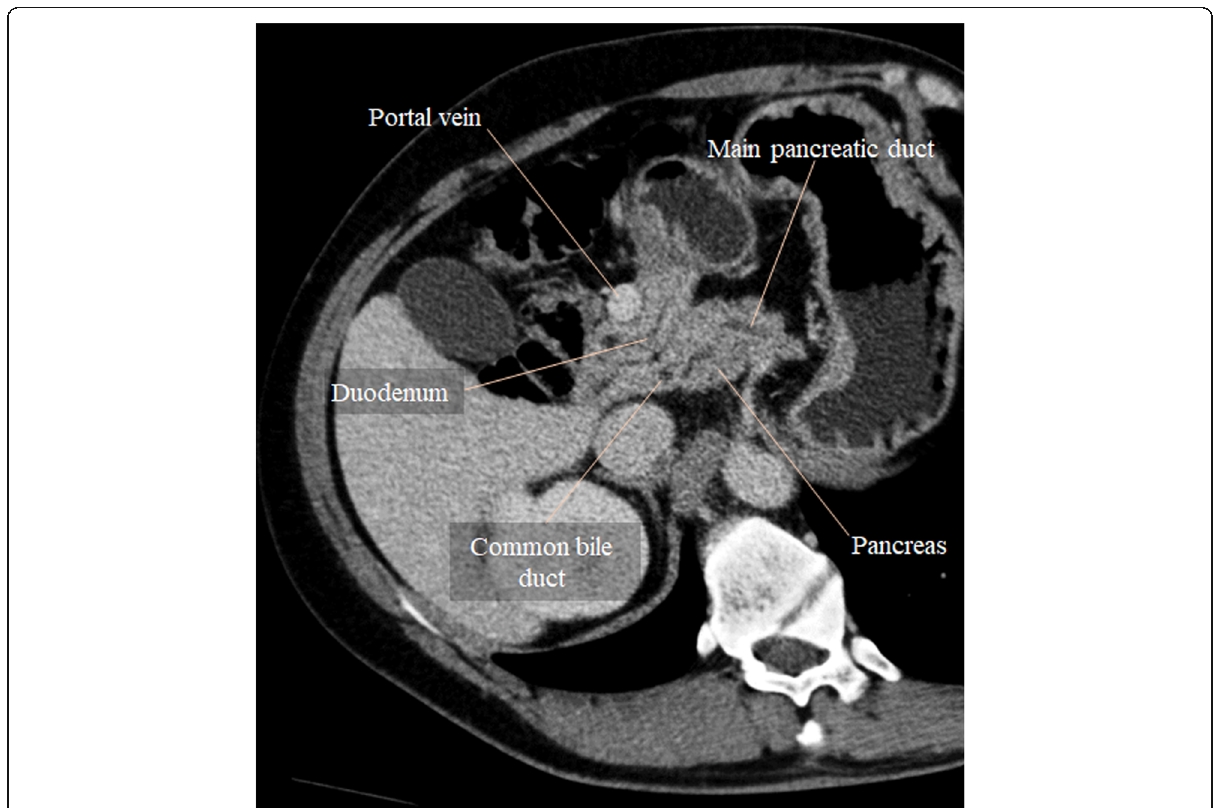
Fig. 4 Preduodenal PV. MPR image from portal venous phase CT shows the main PV coursing in front of the duodenum and pancreas, an incidental finding in this